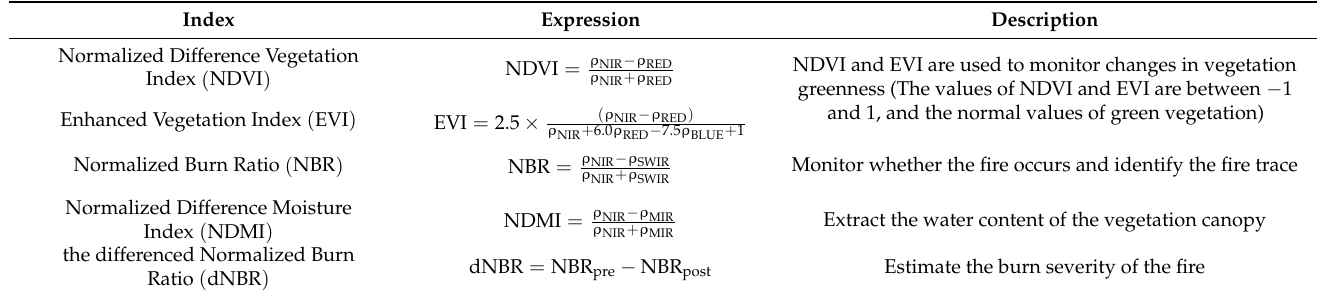
Table 3. Selected remote sensing vegetation indices to detect fire severity in